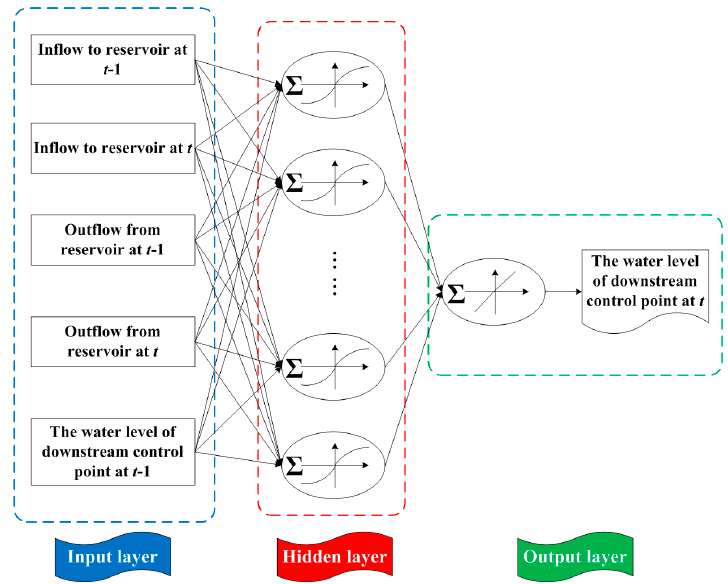
Figure 5. Structure of the back-propagation neural network (BPNN) for water level simulation at a downstream control point.